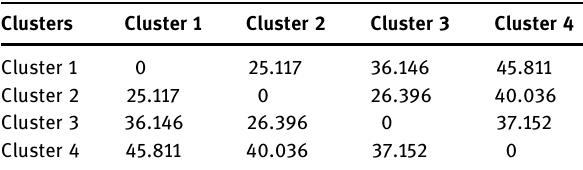
Table 5: Distance between centroids of four clusters of 16 indi - genous barley accessions